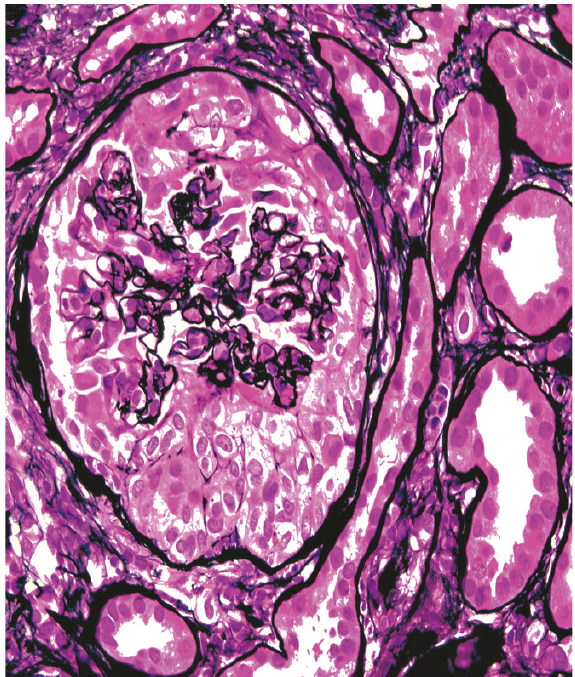
Figure 2: Circumferential cellular crescent is present, associated with collapse of the underlying glomerular capillaries (methenamine silver, x400).